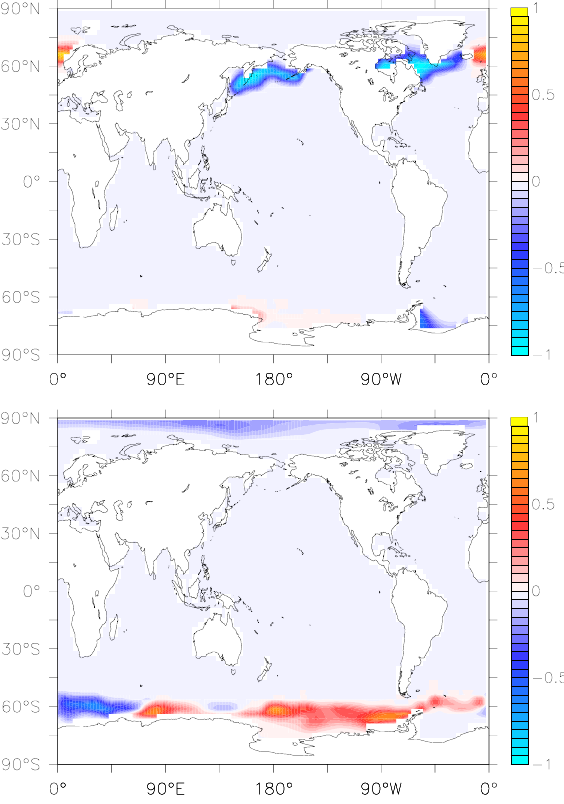
Fig. 23. The change in the sea ice cover in March (top) and September (bottom) of the 2 · CO 2 experiment and the control run.